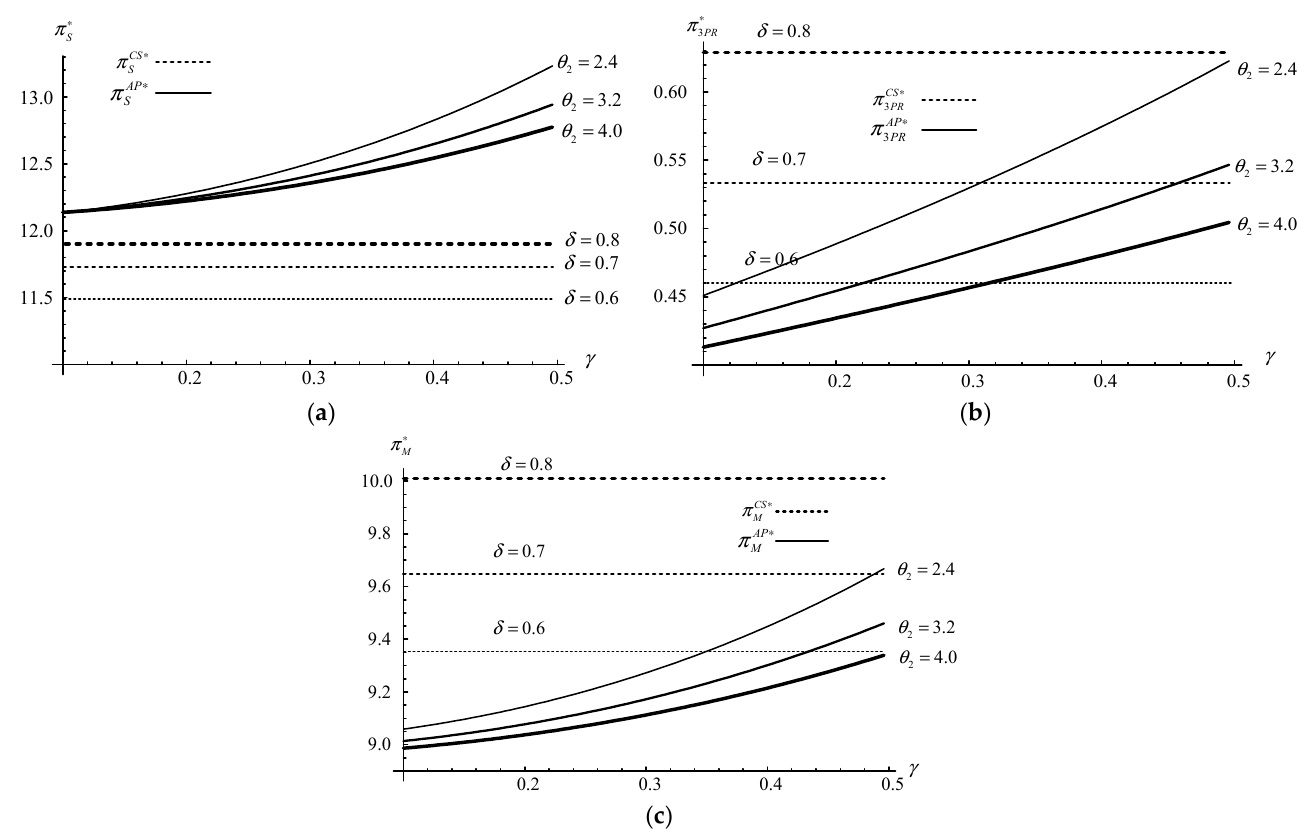
, θ δγ , . ( a ) The supplier’s profit vs. , θ δγ , . ( b ) The 3PR’s profit 2 2 , θ δγ , . 2